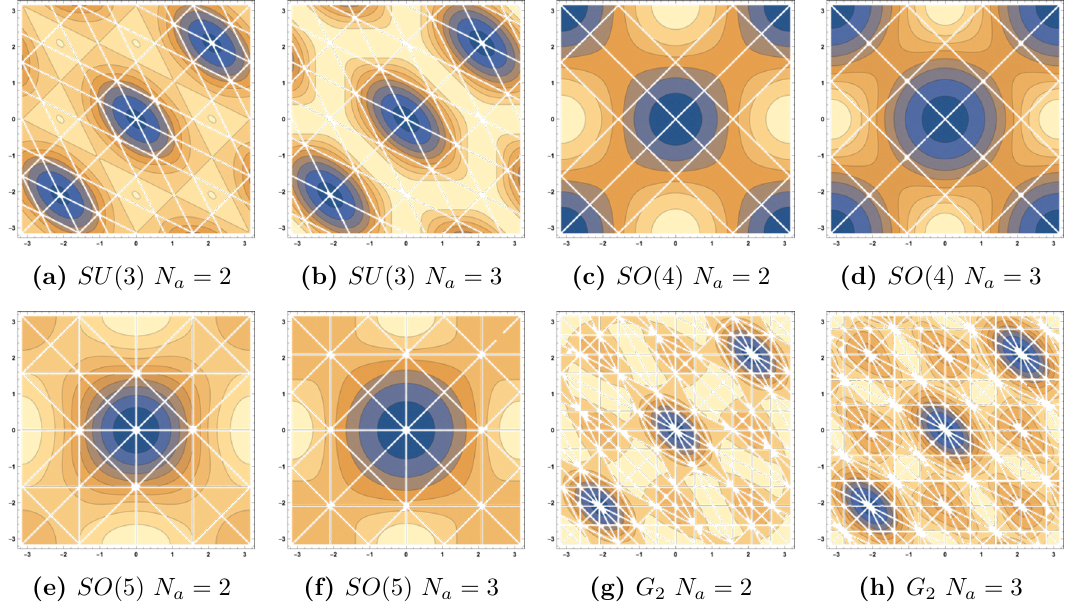
Figure 4. Contour plot of Im F| ∆= − iπ for rank-2 SYM with N a = 2 , 3 adjoint chiral multiplets. Magnetic Pouliot